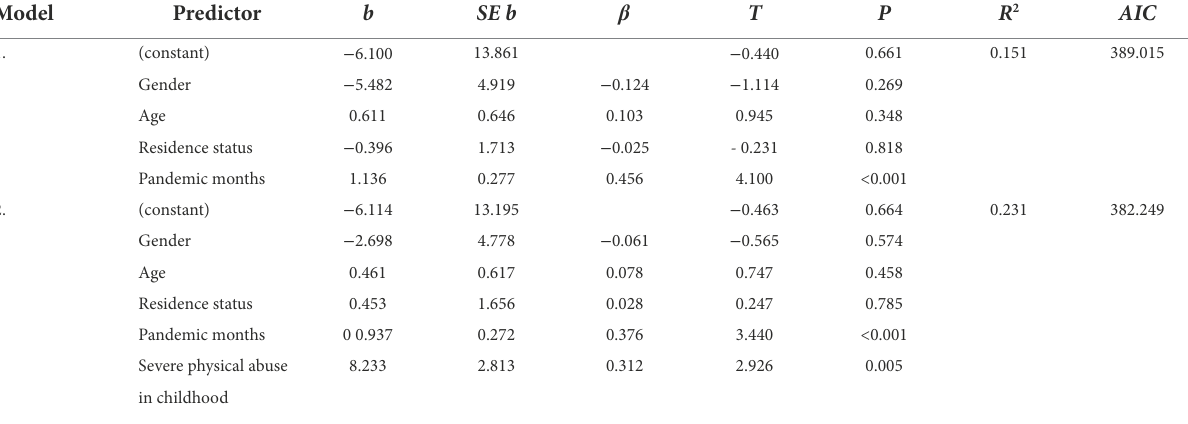
TABLE 2 Regression models of emotional distress on gender, age, residence status, pandemic months, and severe physical abuse in childhood.